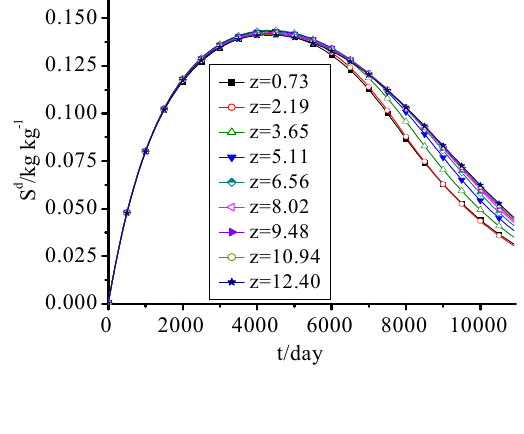
Figure 7. SDS concentration change with time.